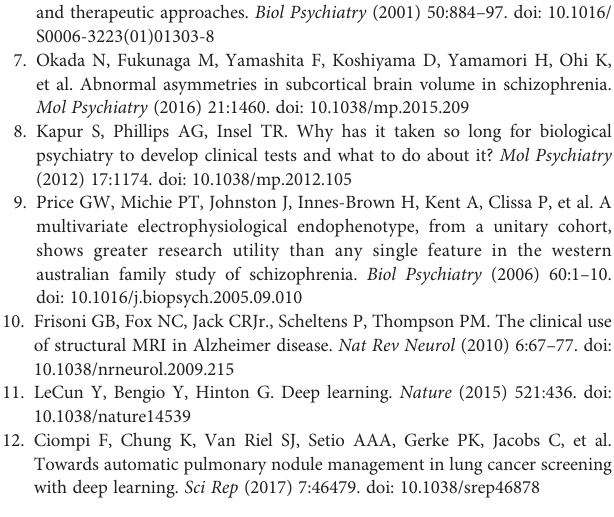
SUPPLEMENTARY FIGURE 1 | A Sample Process of Converting 3D MR Images to Video Format. SUPPLEMENTARY FIGURE 2 | A full model of a deep learning algorithm. SUPPLEMENTARY FIGURE 3 | Learning effect of psychiatrists. SUPPLEMENTARY FIGURE 4 | Training curve of the algorithm. SUPPLEMENTARY TABLE 1 | Scan Parameters of 5 Public Data Sets and Validation Data Set. SUPPLEMENTARY TABLE 2 | Confusion Matrix of Individual Clinicians in Detecting Schizophrenia through MR Images. SUPPLEMENTARY VIDEO 1 | A Sample Video of Converted MR images. SUPPLEMENTARY VIDEO 2 | A Sample Video of Converted MR images with occulded